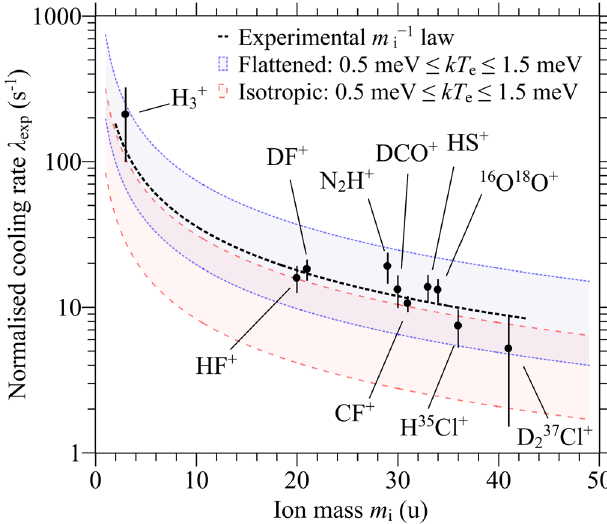
FIG. 7. Overview of the measured normalized cooling rates for magnetic expansion α ¼ 20 . The dots represent the data from Table I. The dotted-black curve is a fit of the measurement to a 1 =m -model as expected from Eq. (12). The shaded areas i delimit the expected rates in the electron temperature interval 0 . 5 meV =k ≤ T ≤ 1 . 5 meV =k for a flattened and isotropic e B B electron velocity distribution, as indicated.